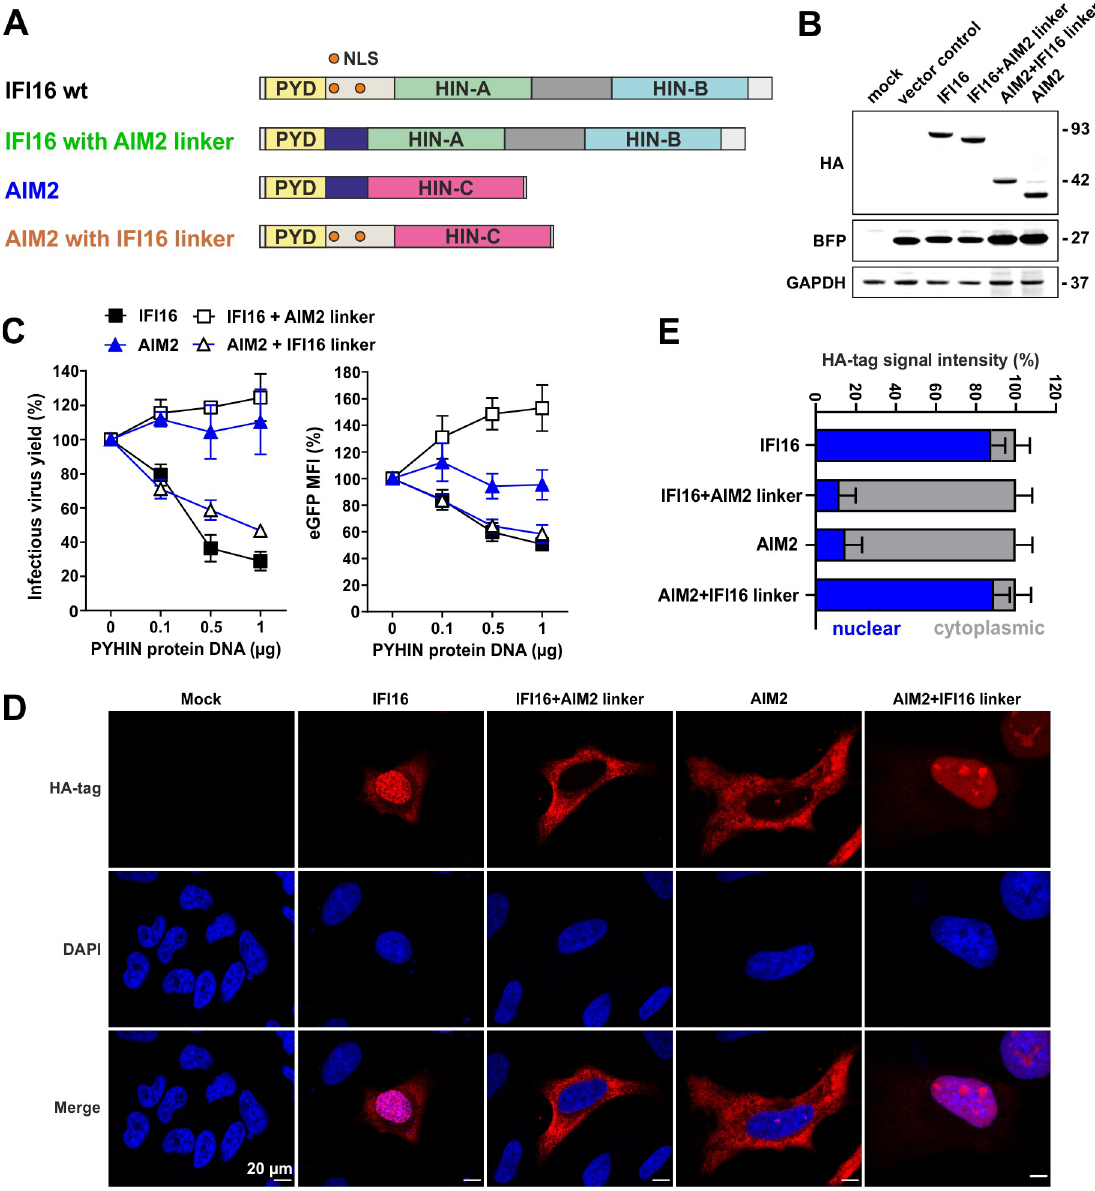
Fig 6. The NLS of IFI16 confers antiretroviral activity to AIM2. (A) Schematic presentation of the parental and chimeric IFI16 and AIM2 proteins analyzed. (B) Expression of parental and chimeric IFI16 and AIM2 proteins. HEK293T cells were transfected with IRES-BFP constructs expressing the indicated proteins and examined by Western blot. BFP and GAPDH were used as controls. (C) Antiviral activity of parental and chimeric IFI16 and AIM2 proteins in HEK293T cell. Cells were cotransfected with the indicated PYHIN-IRES-BFP expression vectors and proviral HIV-1 NL4-3 IRES-eGFP constructs. 40 h post transfection, infectious virus yield was determined by infection of TZM-bl cells (left) and LTR-dependent eGFP expression by FACS (right). Mean fluorescence intensities (MFIs) of eGFP expression were measured in the BFP+ population and normalized to the MFI detected in the presence of the empty control vector (100%). Shown are average values ( ± SEM) from triplicate experiments. (D) HeLa cells were transfected with expression construct for the indicated PYHIN proteins. 48 hours post transfection, cells were fixed and stained for the HA-tag (Cell Signaling). DAPI staining was used to stain DNA. Images were taken using the LSM710 confocal microscope (Carl Zeiss) (63x magnification) and HA signal was quantified with Fiji. n = 3 (30–50 cells/sample ± SD). The scale bar represents 20 μ m. (E) Distribution of the indicated proteins in the nucleus and cytoplasm.